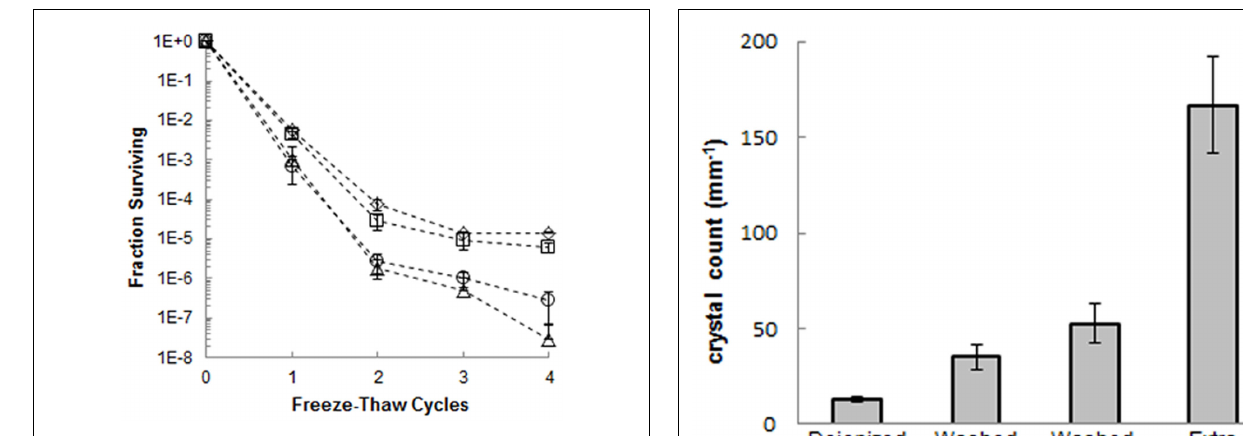
FIGURE 5 | Fraction of E. coli surviving four freeze-thaw cycles in the presence of 100 μ gmL − 1 of extracellular proteins harvested from a culture of 3519-10 grown at 4˚C ( ♦ ) and 25˚C ( (cid:2) ), as well as 100 μ gmL − 1 BSA( Δ ). The bars represent the SE of triplicate samples; the frozen control ( ◦ ) is the average of six replicates from two experiments.